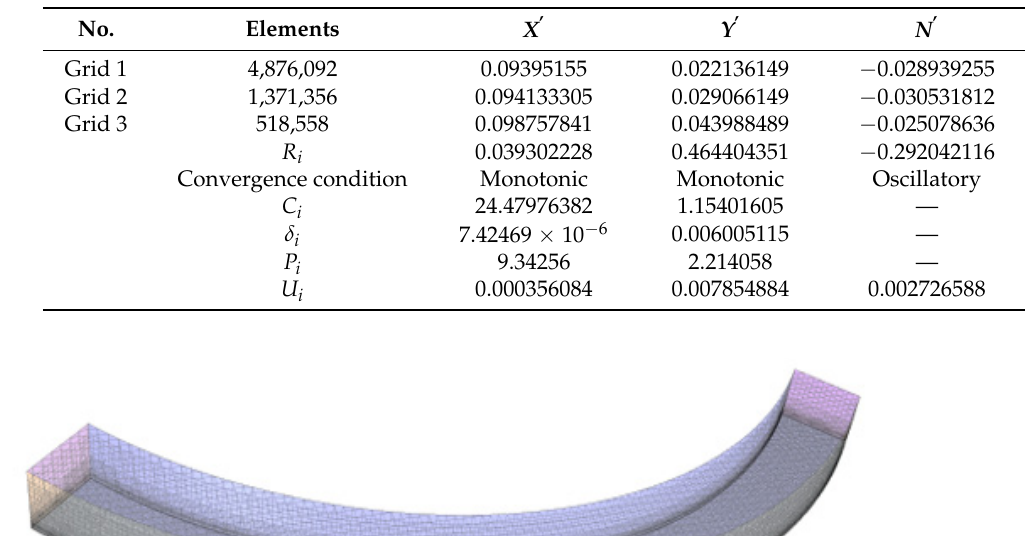
Table 3. Mesh verification results and analysis for X (cid:48) , Y (cid:48) , N (cid:48) .